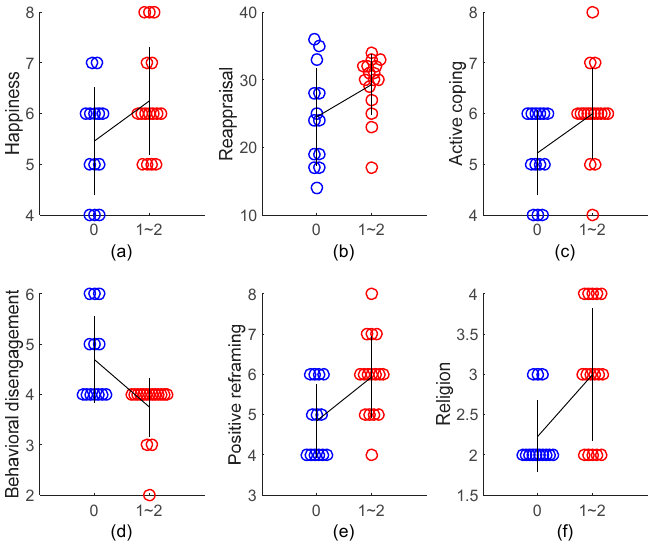
Figure 2. Comparison of happiness ( a ), reappraisal ( b ), active coping ( c ), behavioral disengagement ( d ), positive reframing ( e ), and religion ( f ) between subjects who conducted 0 (n = 13) versus 1~2 days (n = 16) of MVPA per week. Happiness is a submeasure of emotional contagion (ECS); reappraisal is a submeasure of emotion regulation (ERQ); the remaining are submeasures of coping (COPE). Each circle represents one data point from a single subject. Color indicates different groups. The black line connects the two groups at their mean value, and the vertical bar drawn on the mean value represents SD of subjects in that group. Student’s t -test, all p < 0.05 except happiness, p = 0.056 and reappraisal, p = 0.050. MVPA, moderate- to vigorous-intensity physical activity.